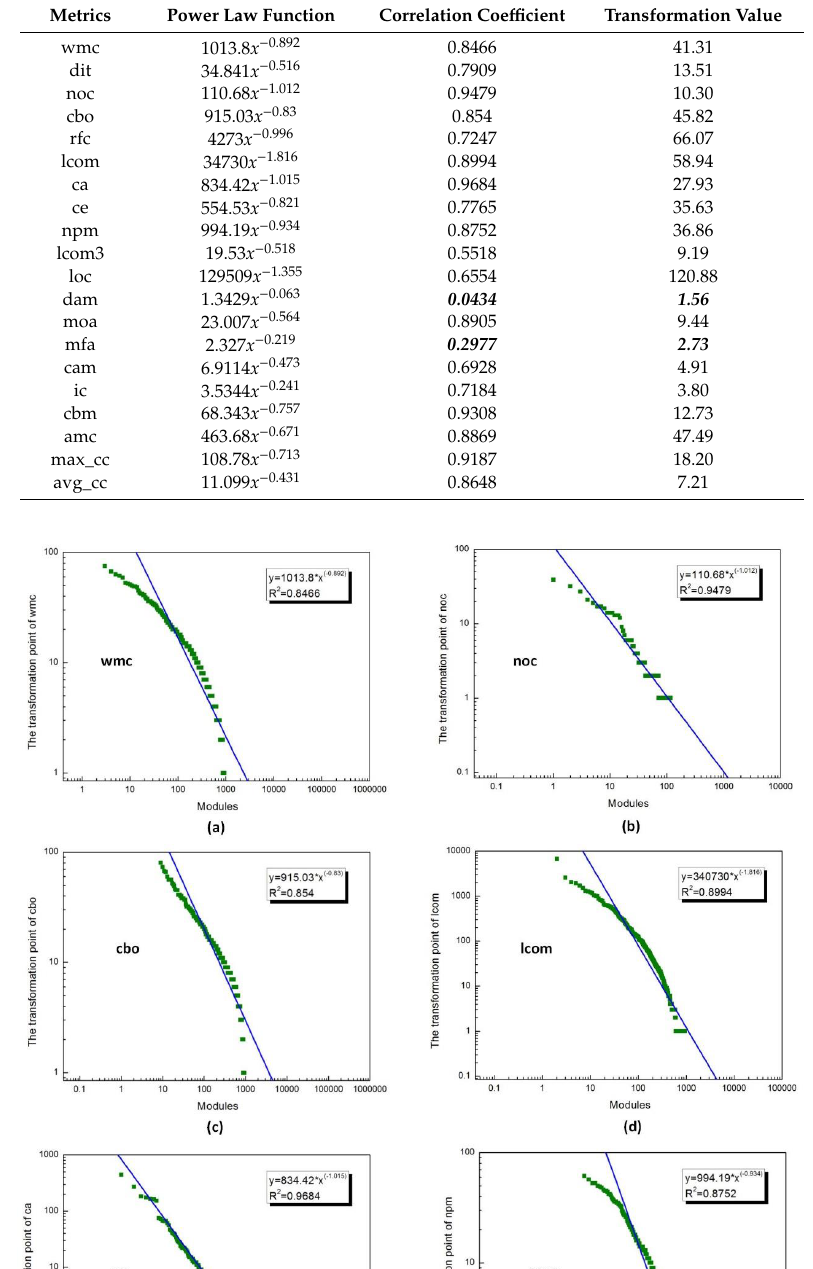
Table 1. Power law function, correlation coe ffi cient, and transformation value in the maximal curvature point. The metrics and their descriptions can be seen in Appendix A.